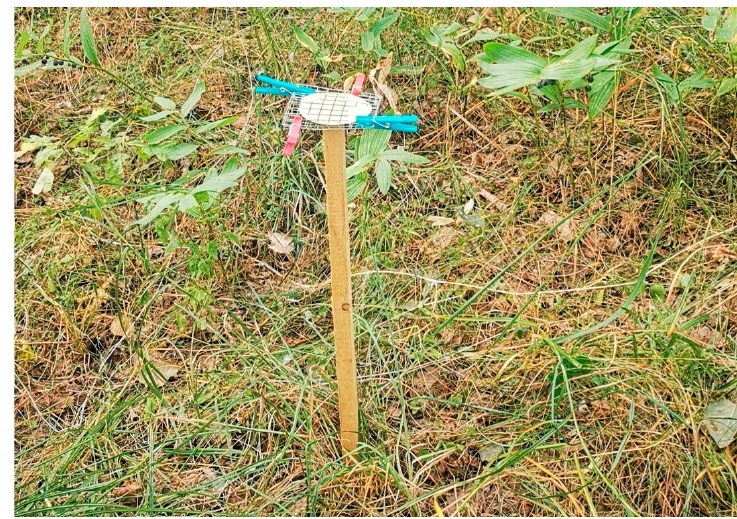
Figure 2. The passive spore trap with a filter paper at the Dubrava study site.